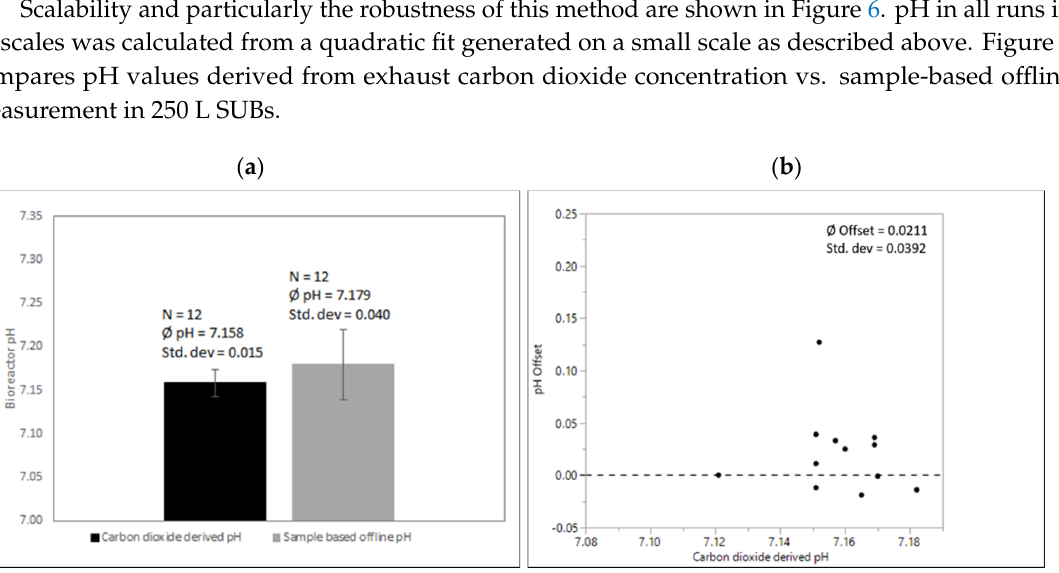
Figure 6. ( a ) Comparison of carbon dioxide-derived and sample-based pH before inoculation after media fill. pH-probe signals were adjusted onto correlation exhaust carbon dioxide concentration and corresponding pH in all 250 L SUBs. Processes were executed from various operators over a period of several months with the same culture media recipe and the same conditions at the calibration time point as described above. ( b ) pH offset of sample-based offline values compared to quadratic fit for correlation exhaust carbon dioxide concentration and corresponding pH.